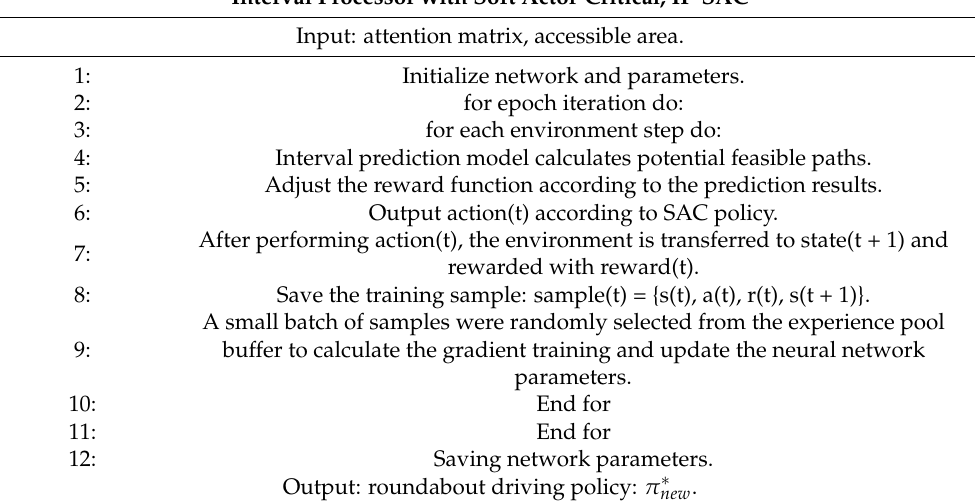
fully connected hidden layer Self-attention network coding layer [64, 64] Self-attention network decoding layer [64, 64] Self-attention network head 2 Self-attention network normalization factor 32 The IP-SAC algorithm pseudocode is shown in Table 4. Table 4. IP-SAC training process. Interval Processor with Soft Actor-Critical,